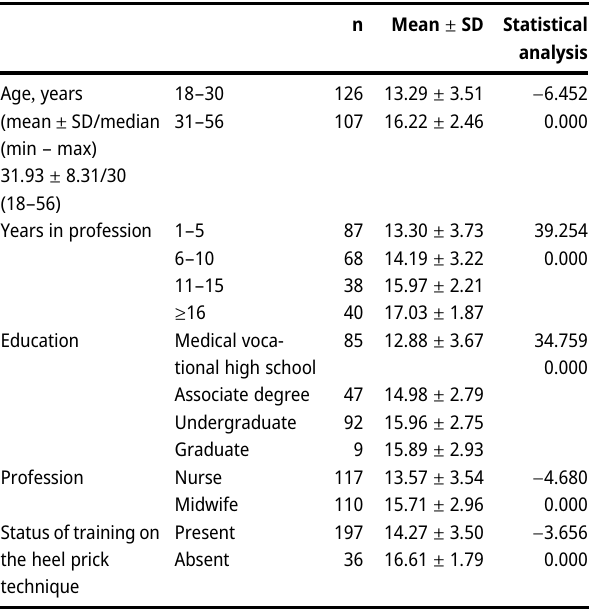
Table  : Analysis of preanalytical phase evaluation form scores of participants according to their socio-demographic